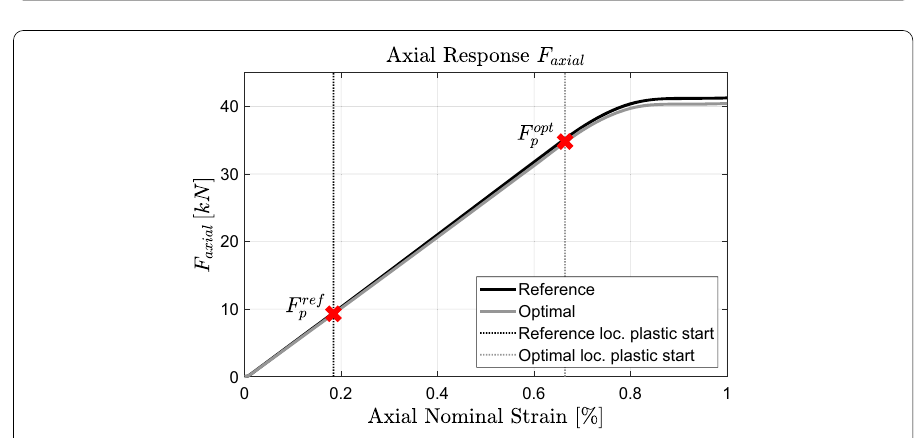
Fig. 11 Accumulated plastic strain. A lower Von Mises stress determines a delayed plastic initiation and a lower overall accumulated strain